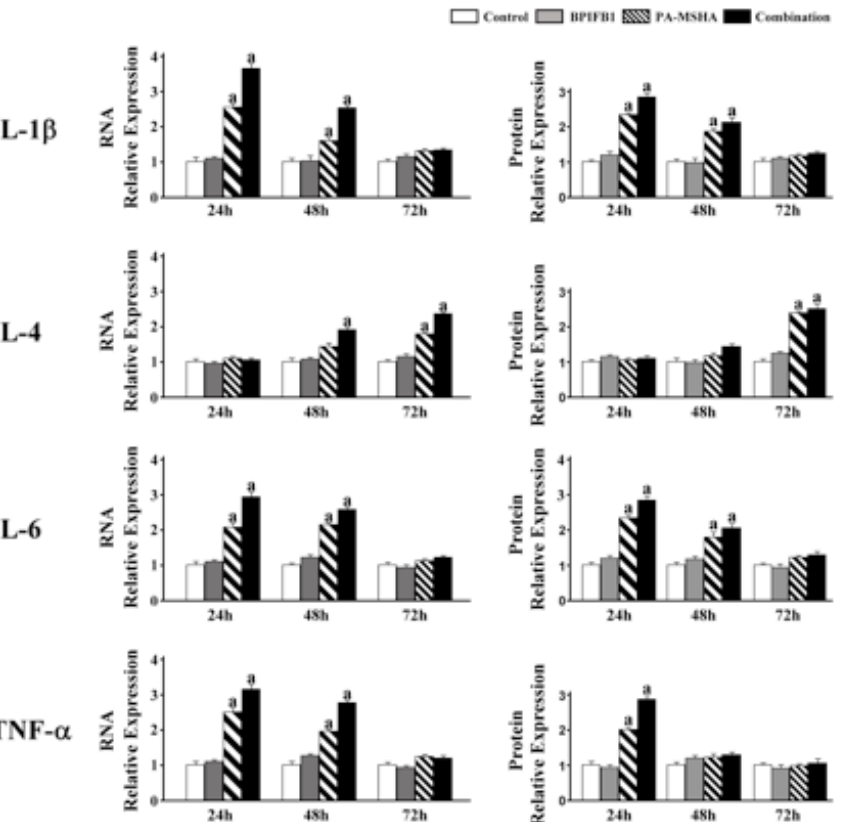
Figure 4: PA-MSHA-BPIFB1 treatment increased the productions of inflammatory cytokines. Differentiated THP-1 cells were incubated with PA-MSHA and BPIFB1 protein as described above. The mRNA and protein productions of IL-1β, IL-4, IL-6, and TNF-α cytokines were assayed by real-time PCR and western blot. Data representative results derived from a minimum of 3 independent experiments. a: p<0.05 compared with none PA-MSHA and BPIFB1